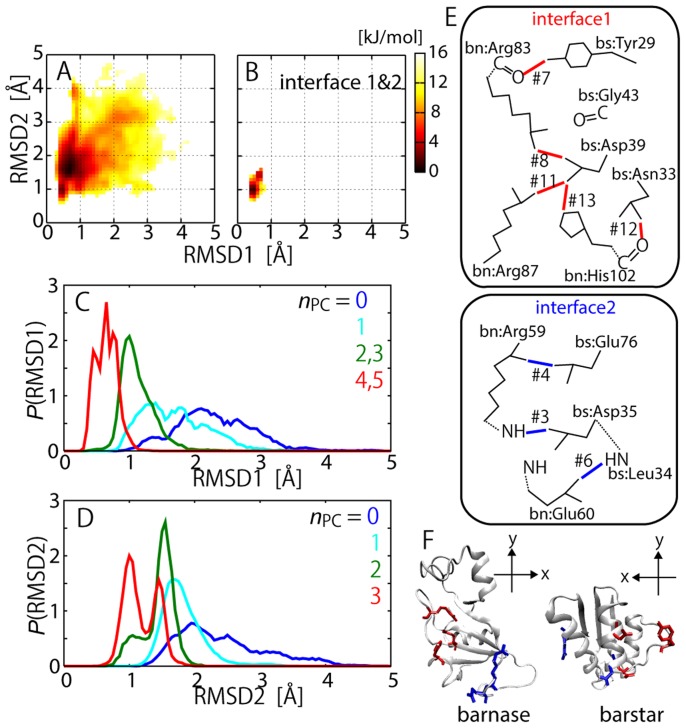
Formations of two localized interfaces.(A) 2D representation of FES along RMSD1 (non-hydrogen-atom RMSD for interface 1) and RMSD2 (non-hydrogen-atom RMSD for interface 2). In (B), the situation is the same but when both interfaces are formed. (C) and (D) show probability distributions along RMSD1 and RMSD2, respectively, when designated number of polar contacts are formed. (E) Native polar contacts at interfaces 1 and 2 (identifier is same as in Table 1). (F) Side-chain positions of interfaces 1 (red) and 2 (blue) of barnase and barstar.